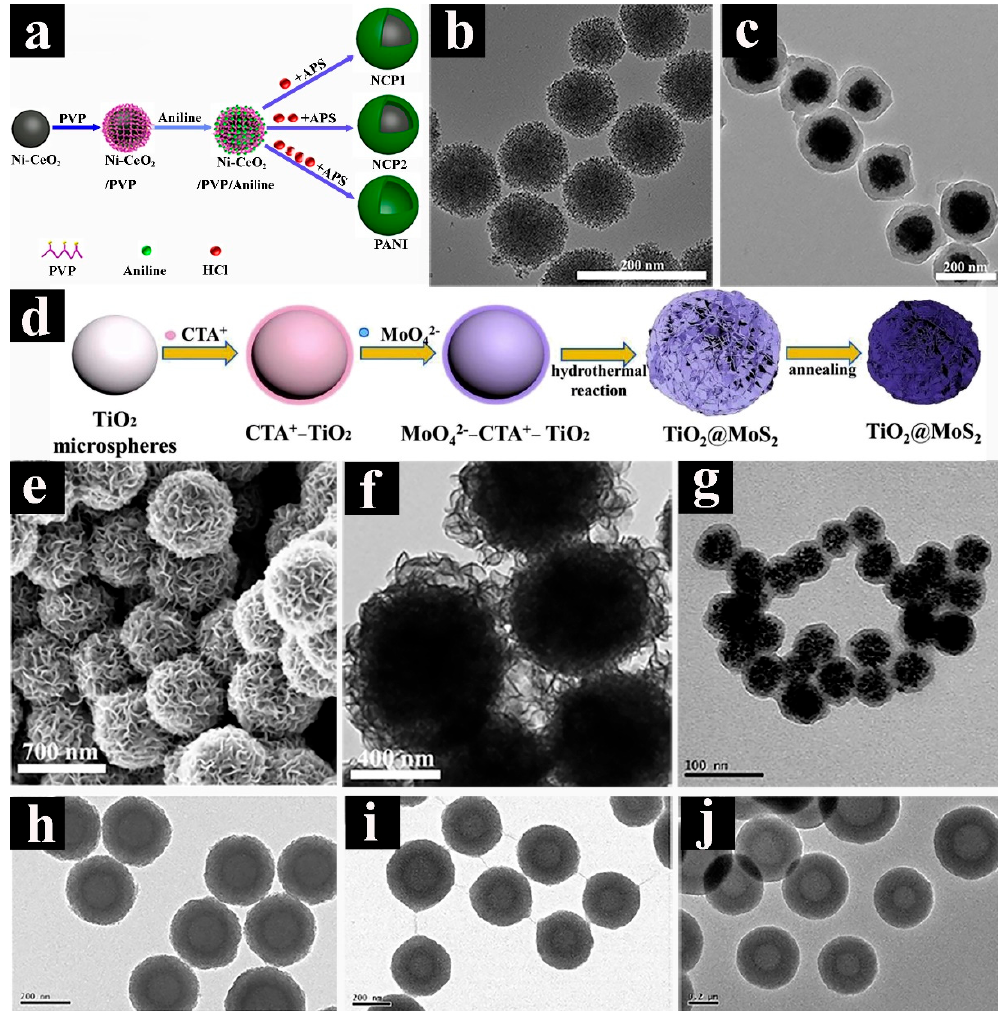
Figure 2. Schematic demonstration and graphical illustration of core-shelled spheres: ( a ) Schematic illustration of the synthesis of core-shelled NCP1, yolk-shelled NCP2, and PANI hollow nanosphere, ( b ) transmission electron microscopy (TEM) image of Ni-CeO 2 nanospheres, and ( c ) TEM image of the core-shelled NCP1 nanospheres. ( d ) Schematic illustration of synthesis procedure of core-shelled TiO 2 @MoS 2 microspheres, ( e ) scanning electron microscopy (SEM) and ( f ) low-magnification TEM images of the annealed core-shelled TiO 2 @MoS 2 microspheres. ( g ) TEM image of the core-shelled SnO 2 @C nanospheres. TEM images of core-shelled SiO 2 / TiO 2 microspheres with titania shell thickness of ( h ) 61 nm, ( i ) 73 nm, and ( j ) 100 nm. Pictures ( a ), ( b ), and ( c ) were reprinted with permission from Reference [90]. Copyright Elsevier, 2018. Pictures ( d ), ( e ), and ( f ) were reprinted with permission from Reference [91]. Copyright Elsevier, 2016. Picture ( g ) was reprinted with permission from Reference [92]. Copyright the Royal Society Chemistry, 2010. Pictures ( h ), ( i ), and ( j )